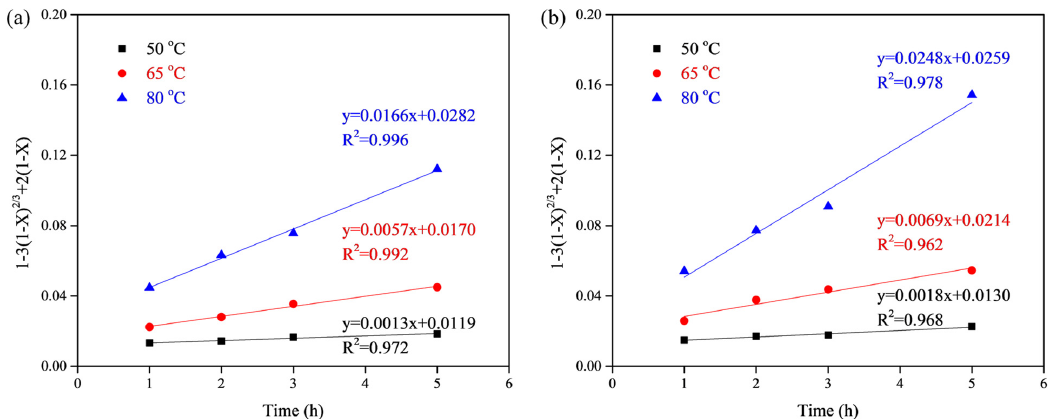
Figure 12. Kinetic constants obtained from fitting the product layer diffusion model (Equation (7)) over time for three temperatures during ( a ) non-UAL and ( b ) UAL.